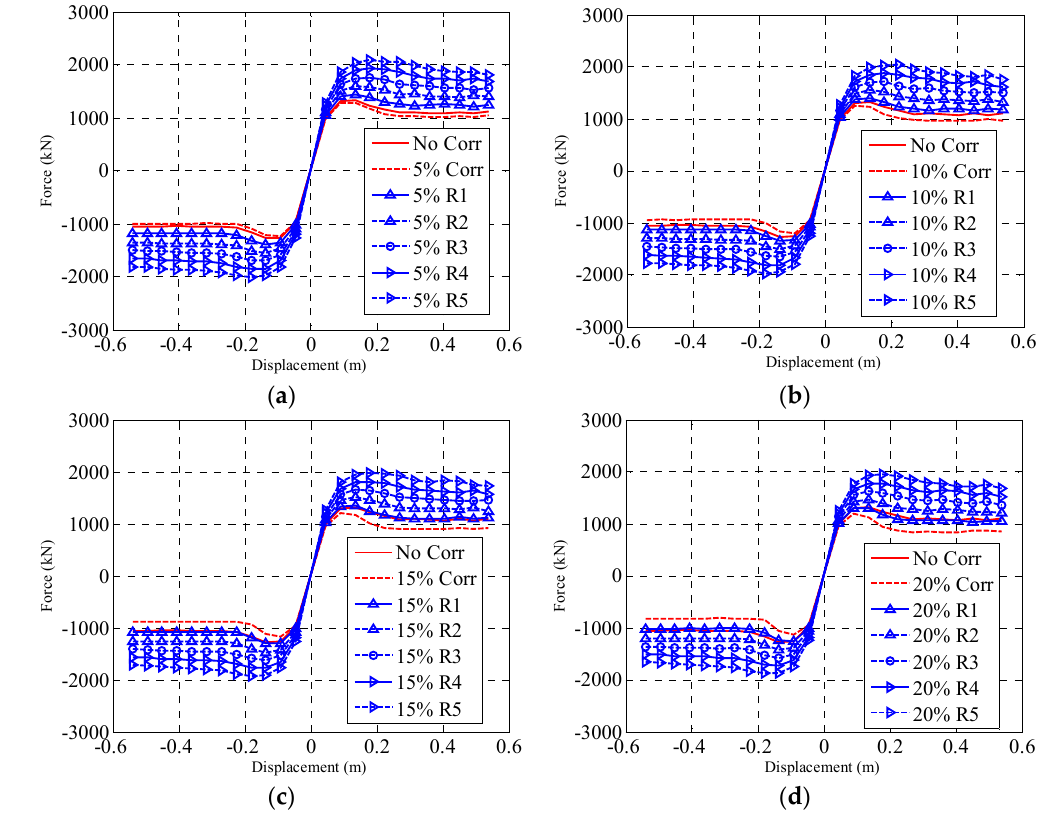
Figure 4. Skeleton curves for a bridge pier with pitting corrosion. ( a ) 5%, ( b ) 10%, ( c ) 15%, ( d ) 20%.